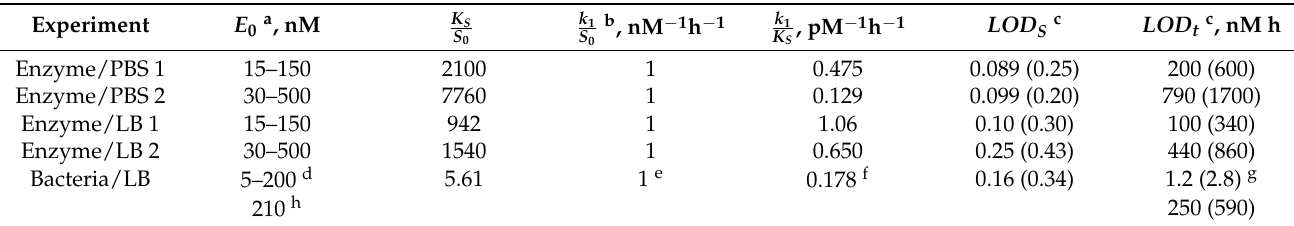
a Range of enzyme concentrations. b Fixed parameter in optimization. c For data in the global fit (all data). d Value d (6). e k 1